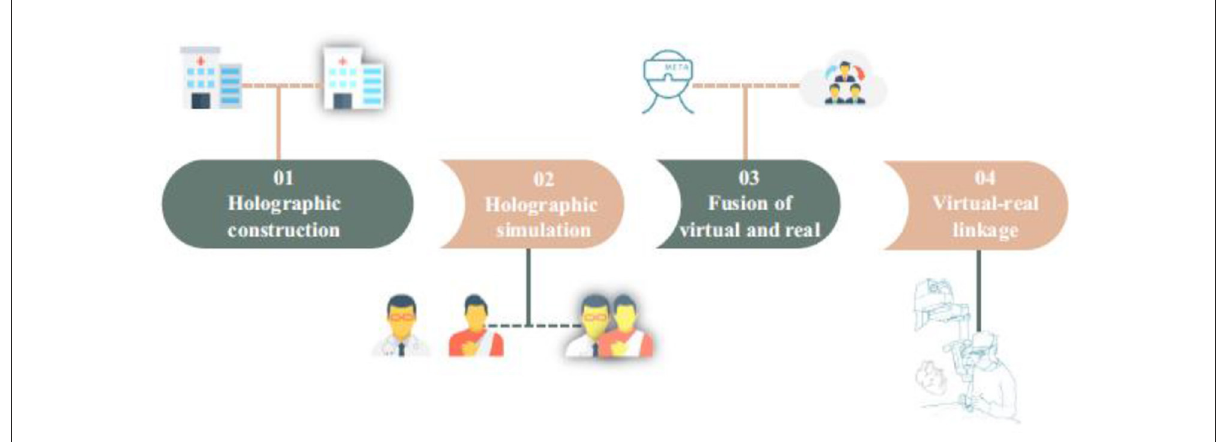
FIGURE1 The four stages of metaverse in medicine.